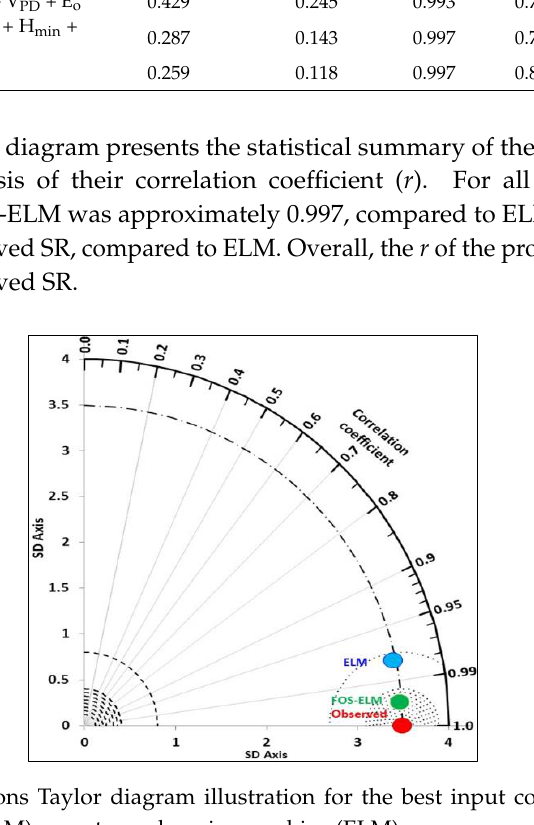
Table 1. The constructed seven input combination model based on the variability influential of each climate information (Several statistical metrics are computed as determination factors. Note, bold line is the best input combination.